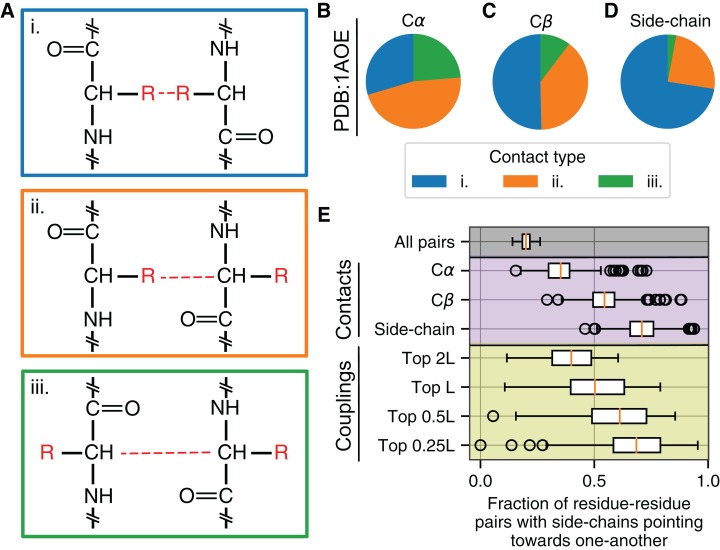
Different types of residue–residue interactions are possible.(A) Two interacting residues may interact via: each residue’s side-chain atoms (type i), the side chain of one residue and the backbone of the other (type ii), or the backbone atoms of each residue (type iii). (B–D) For intramolecular contacts identified in PDB:1AOE, the relative proportion of different interaction types varies according to contact identification method. Shown are contacts identified via Cα atoms (B), Cβ atoms (C), and side-chain centers (D); residue–residue contacts defined via side-chain centers are enriched in type i interactions (blue). (E) For 150 proteins, the fraction of residue–residue pairs where the side chains point toward one-another is highest in contacts defined via side-chain centers (purple). Further, the top ranked evolutionary couplings are progressively enriched in residue–residue pairs where the side chains point toward one another (yellow).